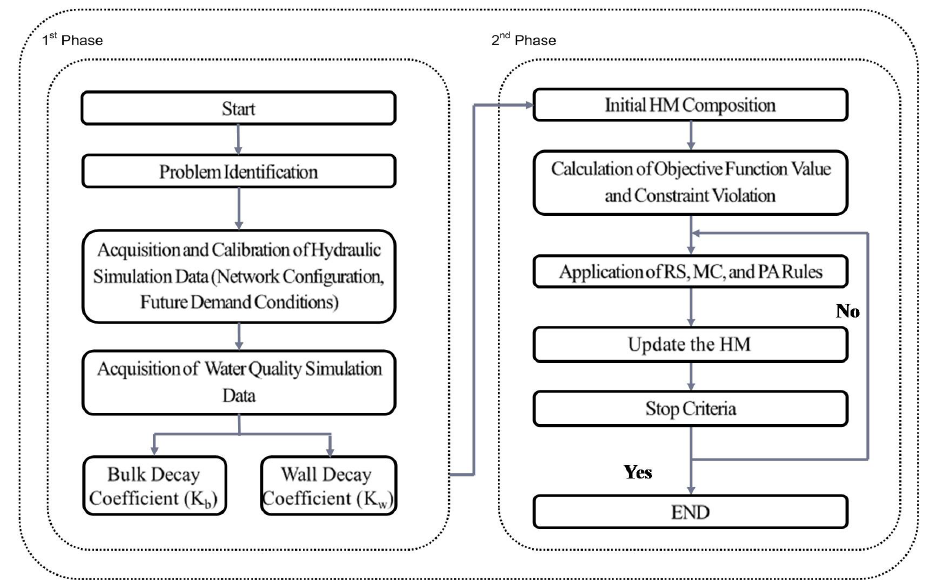
Figure 5. Optimization scheme and flowchart of the proposed model.